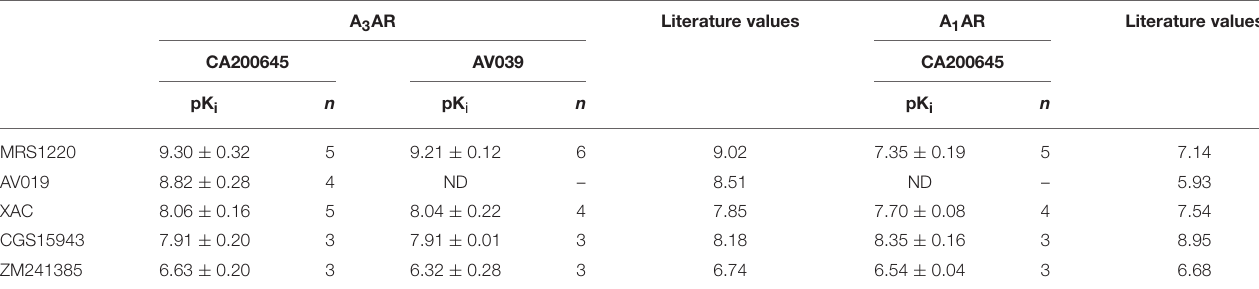
TABLE 1 | Affinity of compounds measured at the A 1 AR and A 3 AR: Affinity values from the PHERAstar HTS assay for unlabeled ligands measured on CHO cells expressing the A 3 AR or the A 1 AR using 25nM CA200645 or 5nM